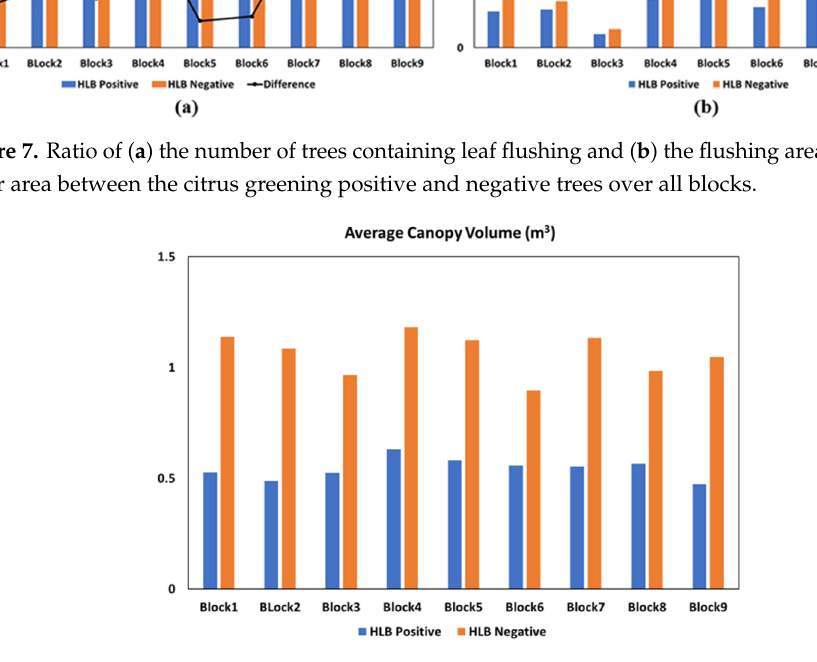
Figure 8. Average canopy volume between the citrus greening positive and negative trees over all blocks.